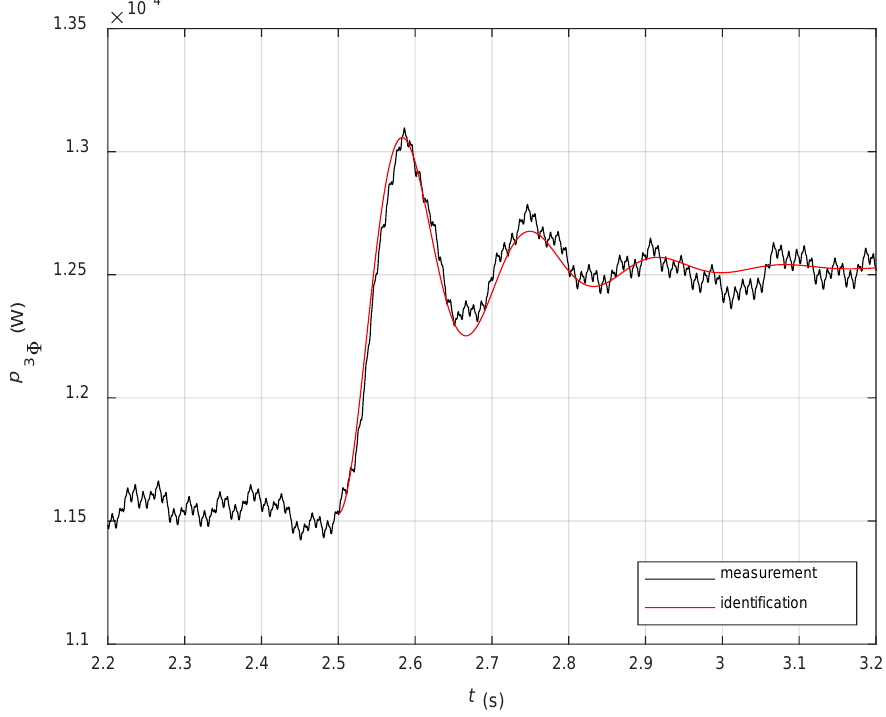
Figure 21. Time response of the instantaneous three-phase power of the laboratory synchronous generator S n = 12 kV in the vicinity of the operating point P = 12 kW, Q = 0 kVAr on the step change of mechanical torque corresponding to mechanical power change from 11.5 kW to 13.5 kW compared with the identified local oscillation.